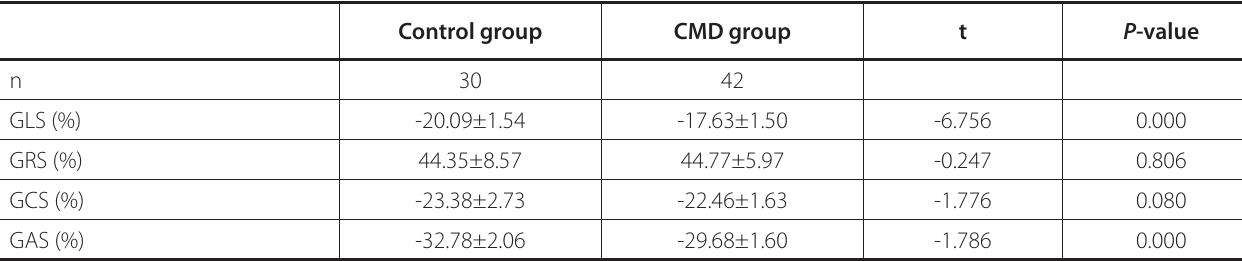
Table 3 . Comparison of left ventricular strain parameters between the